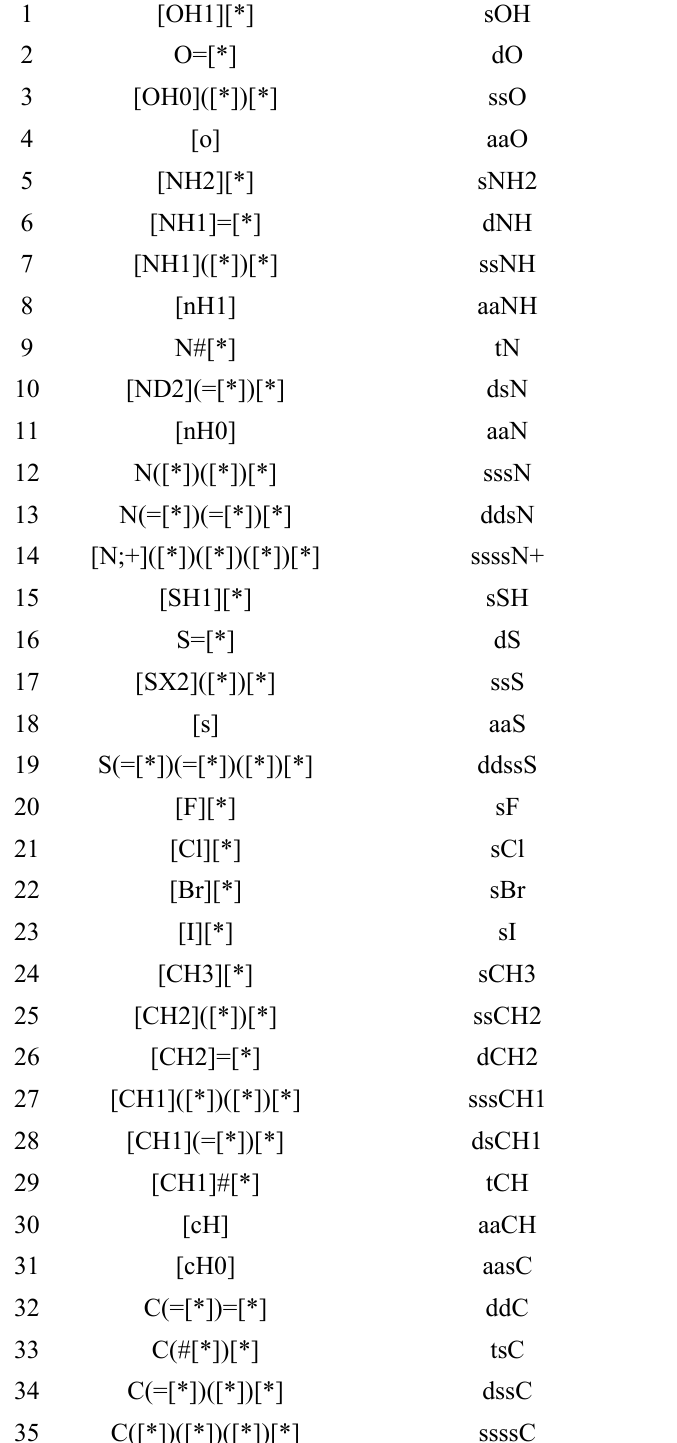
RowNo smarts-definitions